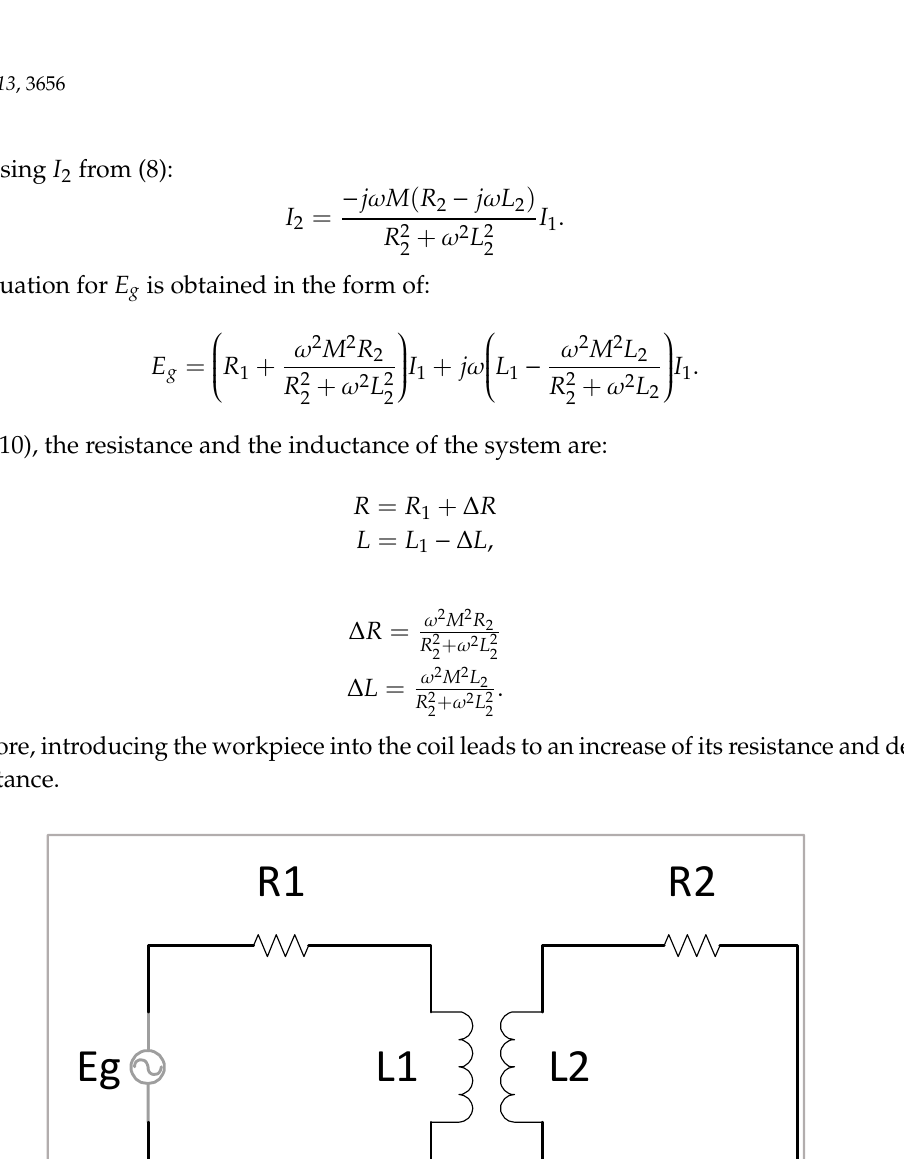
( b ) Figure 10. Power loss—brazing assembly (copper), ( a ) convection, ( b ) radiative. At the end, a heat loss dissipated into the induction coil is shown in Figure 11. Again, only the copper-to-copper case is presented. This estimation is important for induction cooling system evaluation.